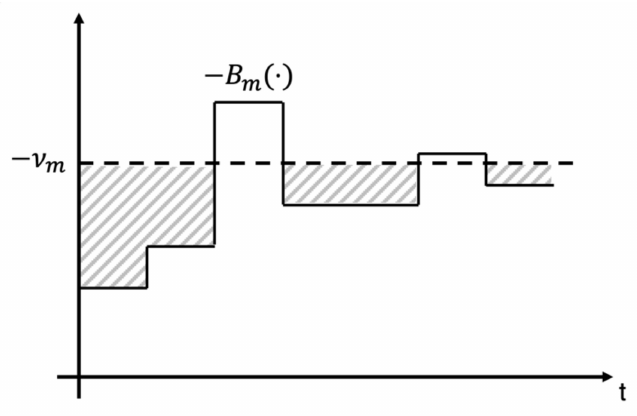
Figure 4. Illustration of the solution as a water-filling